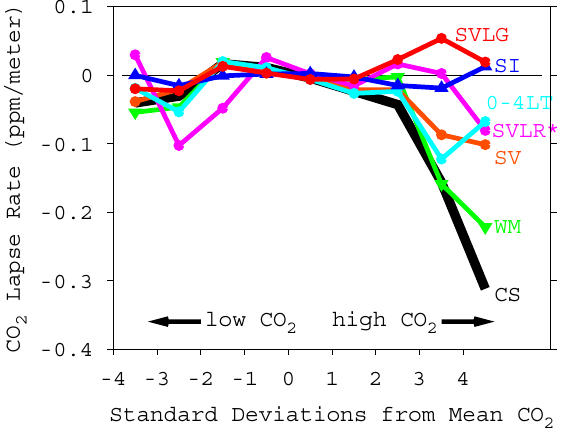
Fig. 5. 20 cases of well-mixed air determined from NOAA air- borne flights above Carr, Colorado are compared against the corre- sponding hourly mean measurements from the Niwot Ridge RAC- COON site for each filtered subset. Subsets are standardized to equal numbers of measurements. The top panel shows (using SVLR) that SVLG, SVLR and WM subsets have roughly simi- lar error from Carr measurements (RMSE ≈ 0.5ppm) from well- mixed cases at Carr. SI and WM subsets show slightly larger bias (RMSE ≈ 0.7ppm) over the same 20 cases. This suggests that when standardized to a common sample size filters are roughly similar in filtering observations representing well-mixed air, and that this does not resolve how stringent the filter criteria should